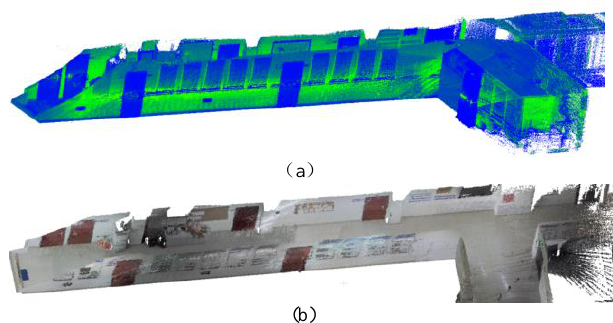
Figure 5. Calibration results for indoor scenes. (a) Point clouds. (b) Fusion